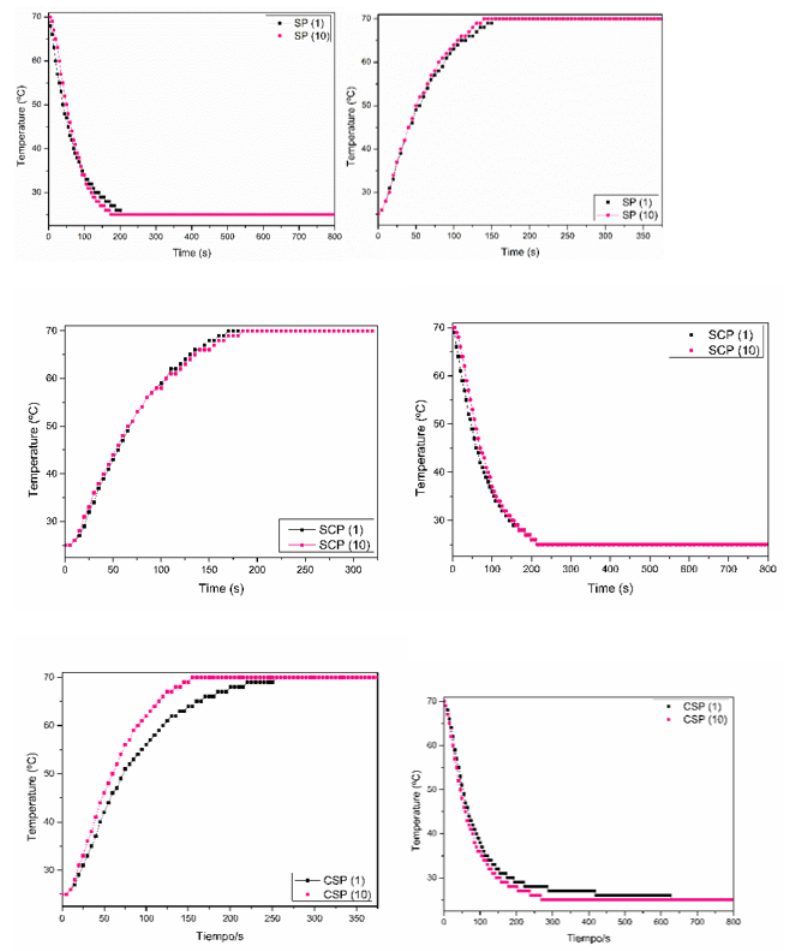
Figure 7. The heating curves ( left ) and cooling curves ( right ) of PCMs after 10